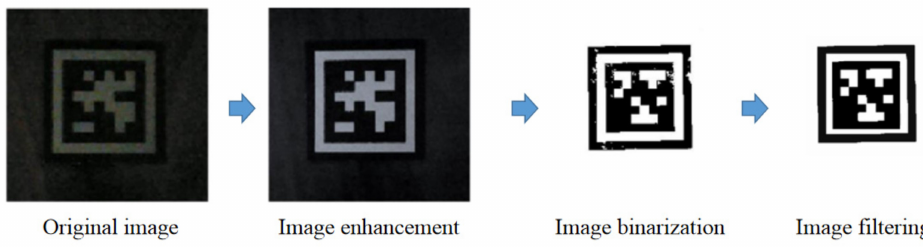
Figure 11. Image processing procedure.